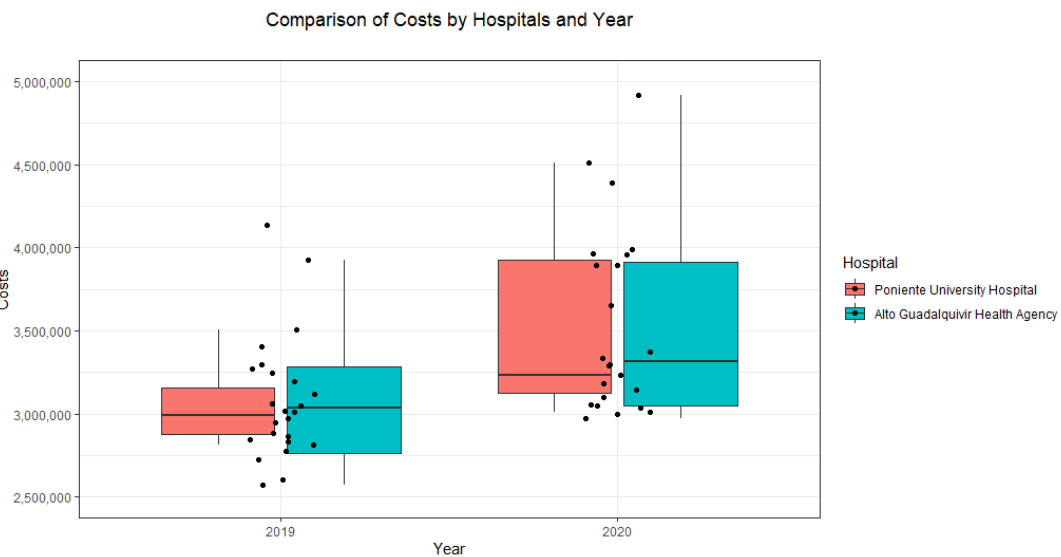
Figure 4. Comparison of costs by year between the regional hospitals.